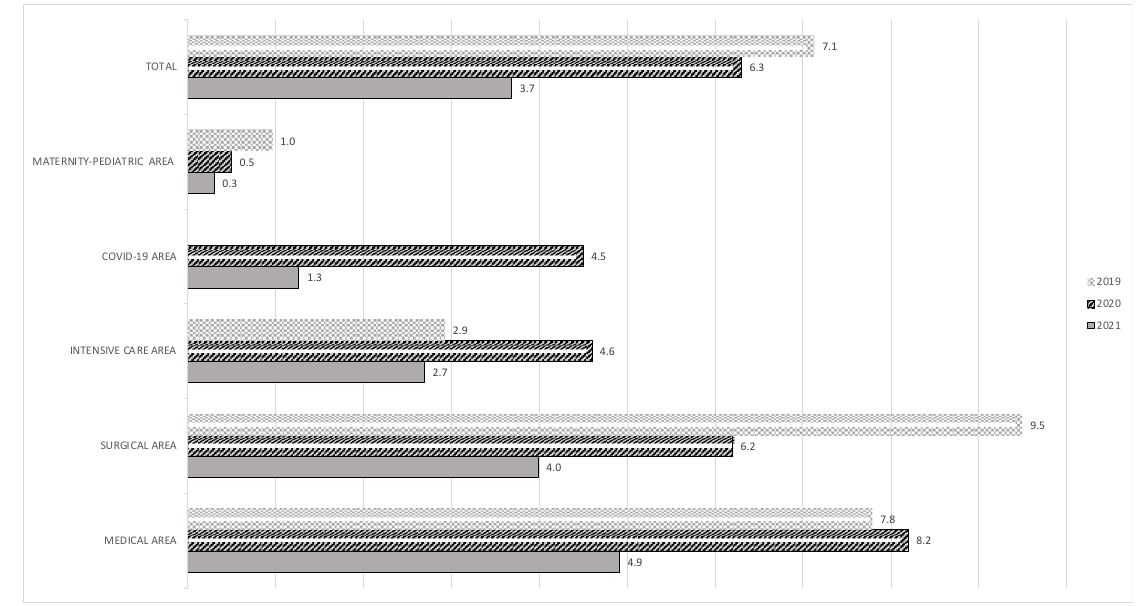
Figure 2. Fluoroquinolones consumption by patient-care area. We identified three wards with critical FQs consumption, two belonging to surgical areas (Units 1 and 3) and one to a medical area (Unit 2). The observed consumption ranged from 81.6 DDD/100 bd (Unit 3) to 32.0 DDD/100 bd (Unit 2) (Table 2). After the intervention, the FQs consumption decreased in all three units, respectively, by 80.0%, (from 67.1 DDD/100 bd to 13.4 DDD/100 bd), 50.3% (from 32.0 DDD/100 bd to Table 2. Fluoroquinolones consumption in defined daily doses (DDDs)/100 bed days at critical FQs consumption units.